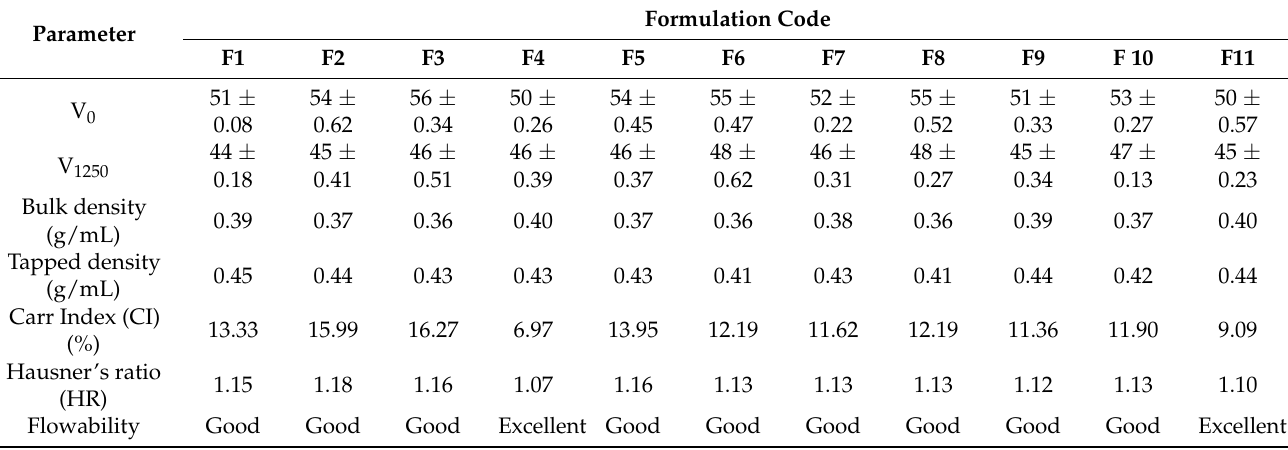
Table 5. Volumetric characteristics for the direct compression